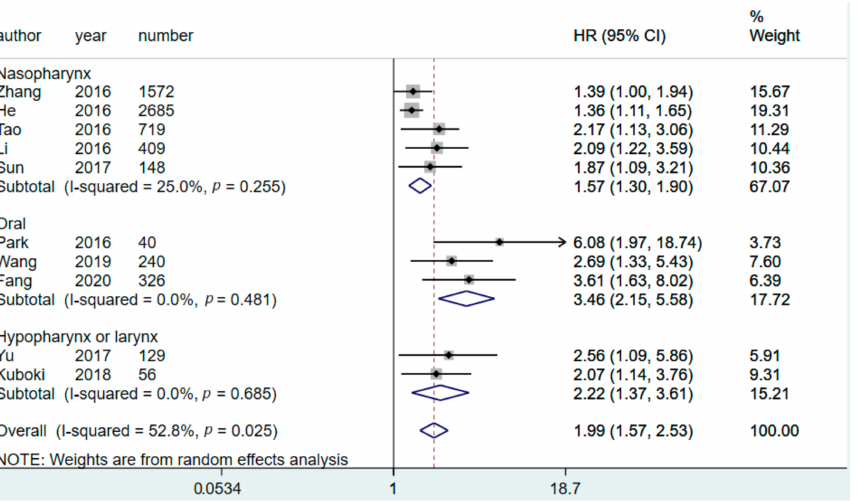
Figure 3. Forest plot depicting the pooled results of HRs for OS related to various tumor locations. HR, hazard ratio; CI, confidence interval; OS, overall survival.